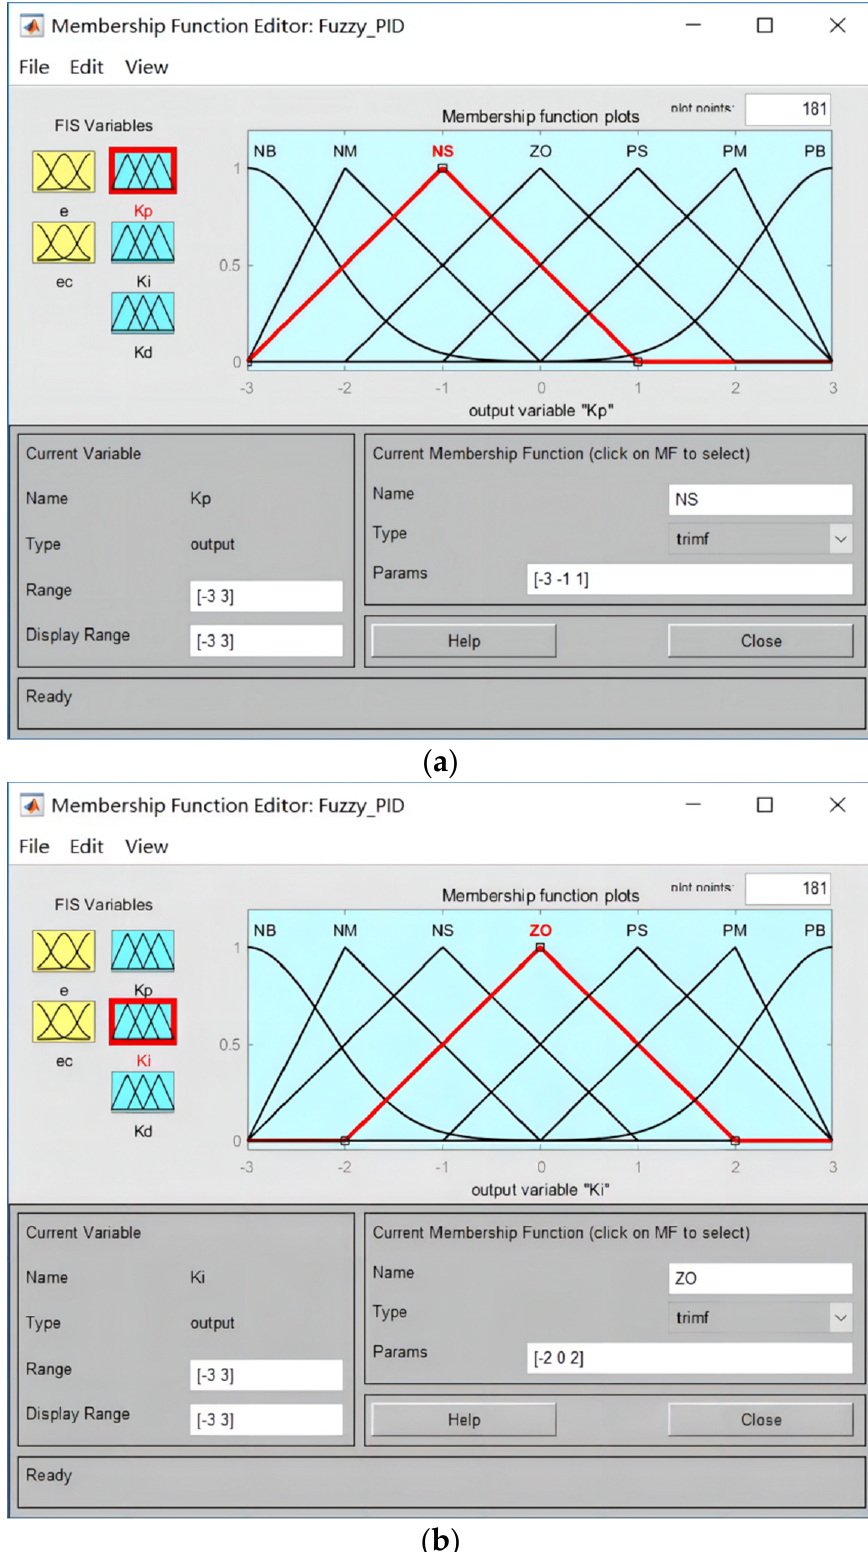
Figure 6. ( a ) Affiliation function curve for output variable Kp . ( b ) Affiliation function curve for output variable Ki .